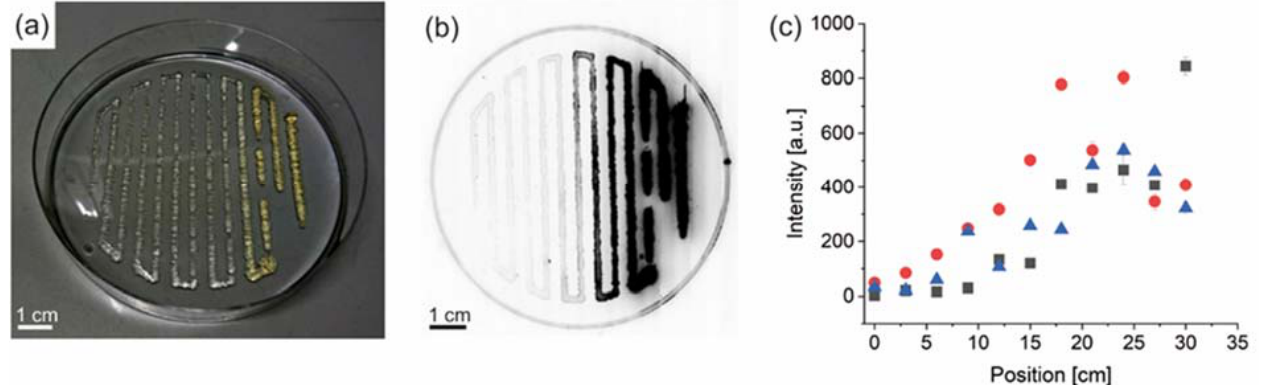
Figure 2. Three ‐ dimensional printed gradient of recombinant spider silk hydrogels (3% w / v ) with one spider silk component fluorescently labeled. ( a ) Photograph of gradient hydrogel constructs from non ‐ labeled (left) to fluorescently labeled spider silk proteins (yellow, right). ( b ) Gradient fluorescence signal visualization of the same sample as in a. ( c ) Quantification of the fluorescence signal at distinct locations along the printed strand from non ‐ labeled (left) to labeled (right) spider silk proteins; red, blue, and black symbols represent measurements for three identical scaffolds as statistic repeats.